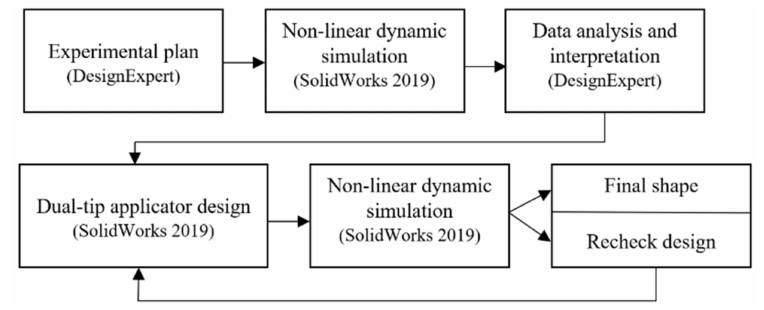
Figure 2. Dual-tip shockwave applicator design steps.